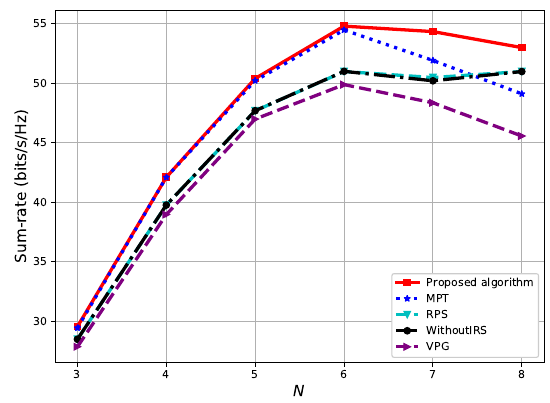
Figure 3. The network sum-rate versus the number of D2D pairs, N .